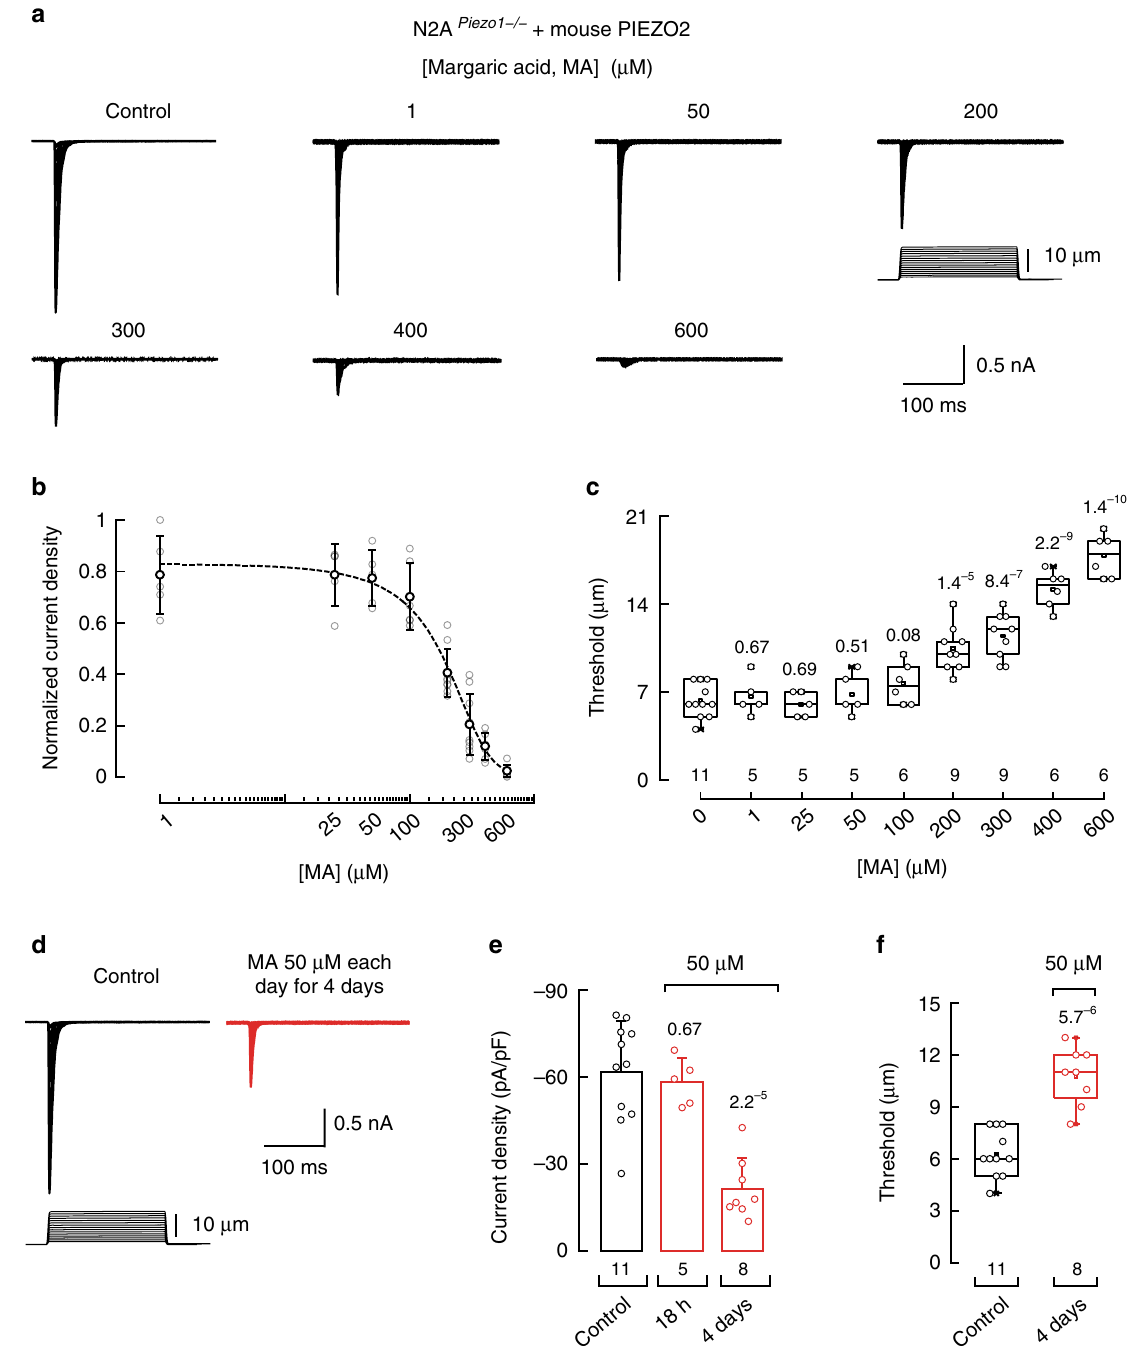
Fig. 1 MA inhibits heterologously expressed mouse PIEZO2 currents in N2A Piezo1 − / − cells. a Representative whole-cell patch-clamp recordings elicited by mechanical stimulation (at − 60 mV) of control and margaric acid (MA)-treated N2A Piezo1 − / − cells transfected with Piezo2 variant 2 (V2). b Normalized current densities elicited by maximum displacement of MA-treated N2A Piezo1 − / − cells transfected with Piezo2 V2. A Boltzmann function, Eq. (2), was fi tted to the data (IC 50 = 190.6 ± 14.7 SEM). Circles are mean ± SD. n is denoted above the x -axis of c . c Displacement thresholds required to elicit PIEZO2 V2 currents of control and N2A Piezo1 − / − cells. Boxplots show mean (square), median (bisecting line), bounds of box (75 th to 25 th percentiles), outlier range with 1.5 coef fi cient (whiskers), and minimum and maximum data points. n is denoted above the x -axis. Two-tailed unpaired t -test. d Representative PIEZO2 currents (at − 60 mV) of control and MA (50 µ M each day for 4 days)-treated N2A Piezo1 − / − cells transfected with Piezo2 V2. e PIEZO2 V2 current densities elicited by maximum displacement of control and MA (50 µ M for 18 h and each day for 4 days)-treated N2A Piezo1 − / − cells. Error bars represent SD. n is denoted above the x -axis. Two-tailed unpaired t -test. f Displacement thresholds required to elicit PIEZO2 V2 currents of control and MA (50 µ M each day for 4 days)-treated N2A Piezo1 − / − cells transfected with PIEZO2 V2. Boxplots show mean (square), median (bisecting line), bounds of box (75 th to 25 th percentiles), outlier range with 1.5 coef fi cient (whiskers), and minimum and maximum data points. n is denoted above the x -axis. Two-tailed unpaired t -test. p -values are denoted above the boxes and